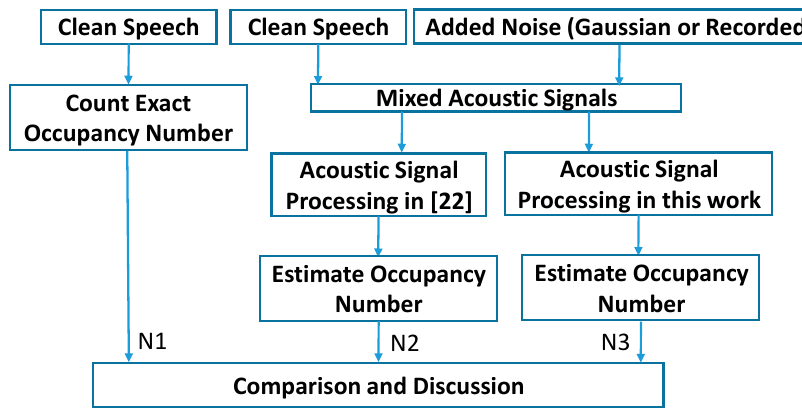
Figure 3. Comparison among occupancy number identification and estimation results.